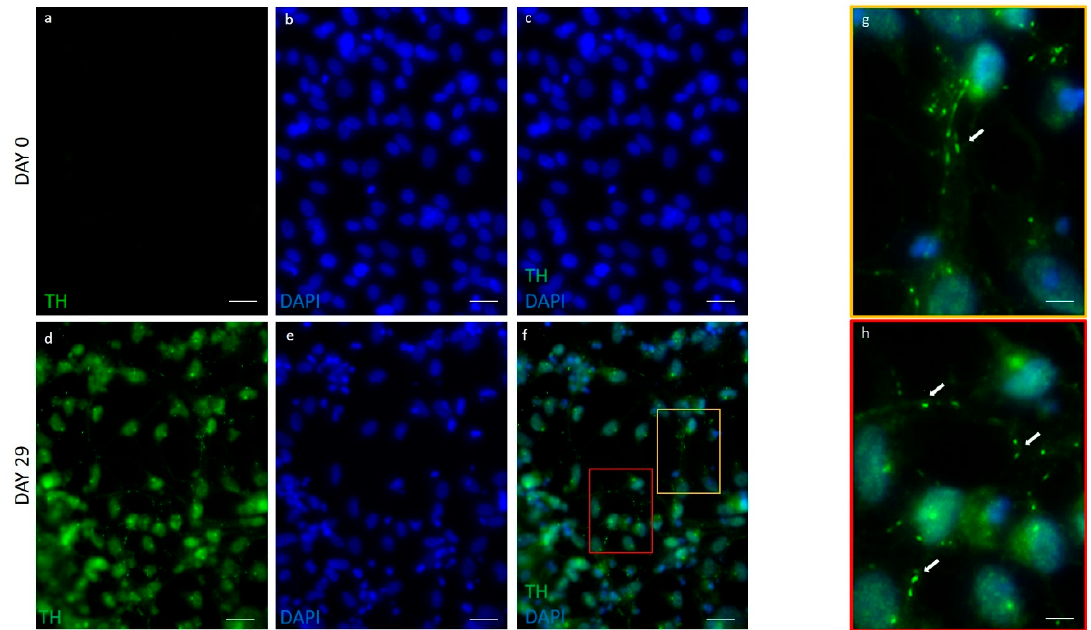
Figure 6. Immunofluorescent analysis of TH in hFM-MSCs-derived DA neuron-like cells. Immunostaining for TH (green) in undifferentiated cells (day 0) and in DA neurons (day 29). The nuclei were counterstained with DAPI. Original magnification: 40× in ( a – f ), scale bar 20 μ m. ( g ) and ( h ) are higher magnifications (60×) of the red and yellow rectangles in f, scale bar 10 μ m. White arrows indicate TH expression along the axons. Immunofluorescence images are representative of three independent experiments .